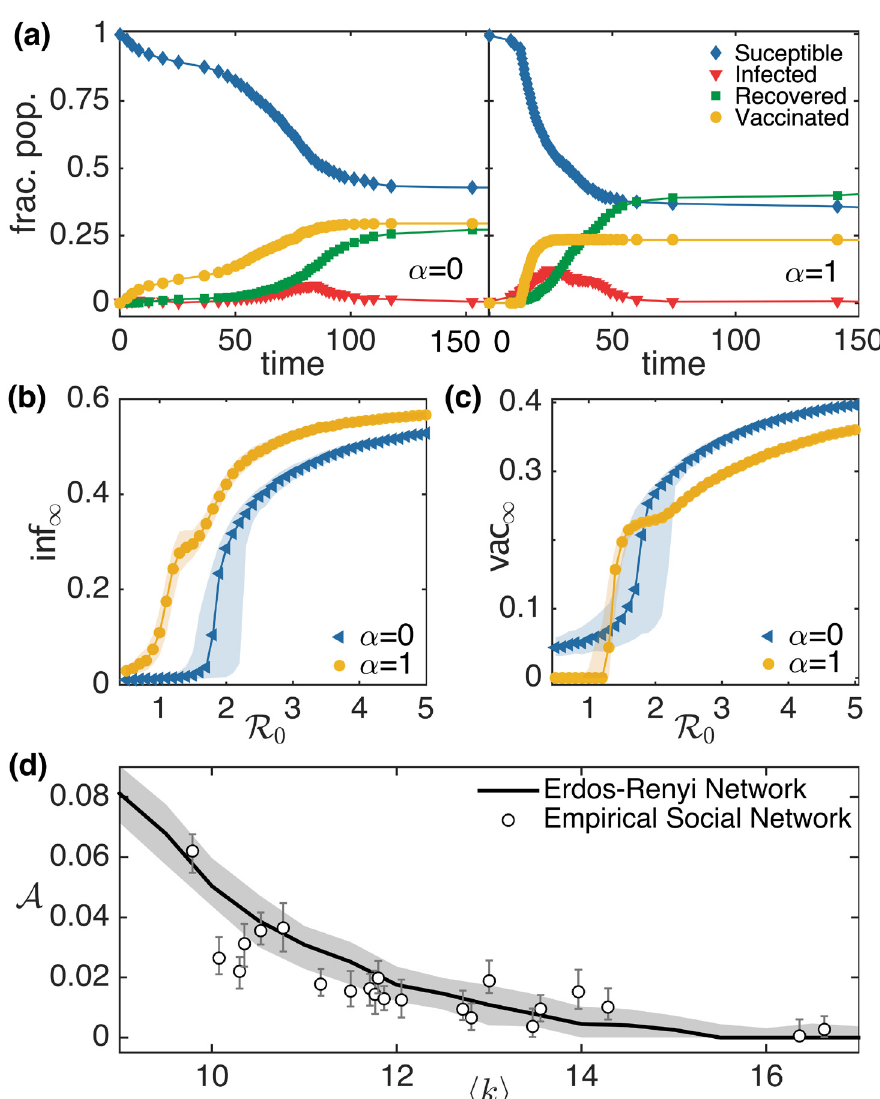
Fig 3. Simulation results for the co-evolution of epidemic spreading and vaccine uptake behavior in Erd ő s-Re´nyi networks. (a) A sample time series showing the evolution of S , I , R and V for a simulated epidemic with β = 0.02 and τ I = 10 in random networks with N = 1024 and h k i = 10 is displayed for α = 0 (left) and α = 1 (right). We display a comparison of the final fraction of agents that are (b) infected inf 1 and (c) vaccinated vac 1 during a simulated epidemic with different values of R , for α = 0 and α = 1. Each point represents the median of 1000 simulation runs 0 and the patches indicate the corresponding IQR. (d) Dependence of crossover area A on average node degree h k i behaves similarly in empirical social networks and model random networks. The solid line and patch shows the median and IQR of the 1000 simulated epidemics on Erd ő s-Re´nyi networks respectively. The circle and error bars represent the median and IQR of the 1000 simulated epidemic on social network of villages in southern India that have a largest connected component greater than 1000.